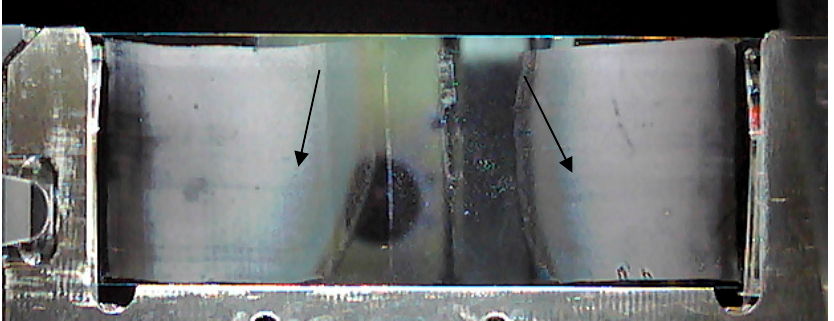
Figure 1. Two-microliter blood drops smeared on two ends of the same indium tin oxide (ITO) slide, with the arrows pointing to optimal cell dispersion zones: cells lying close to each other disable unequivocal mass spectrometry imaging (MSI) analysis, while too much dispersion of cells yields too few cells.